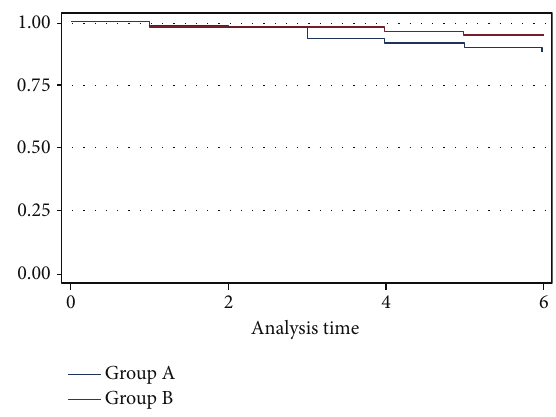
Figure 1: KM estimates survival rates.